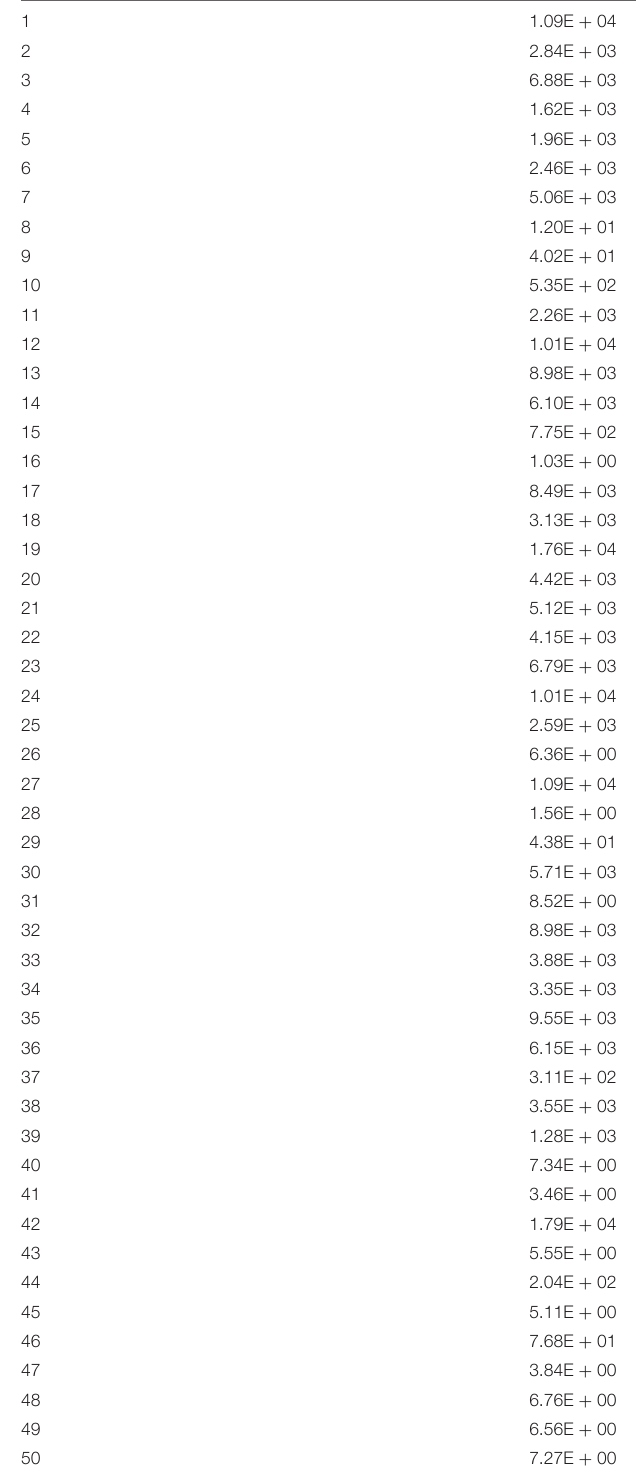
TABLE 2 | Viral genome copies in the salivary glands of viruliferous leafhoppers during the intermittent period. Insect